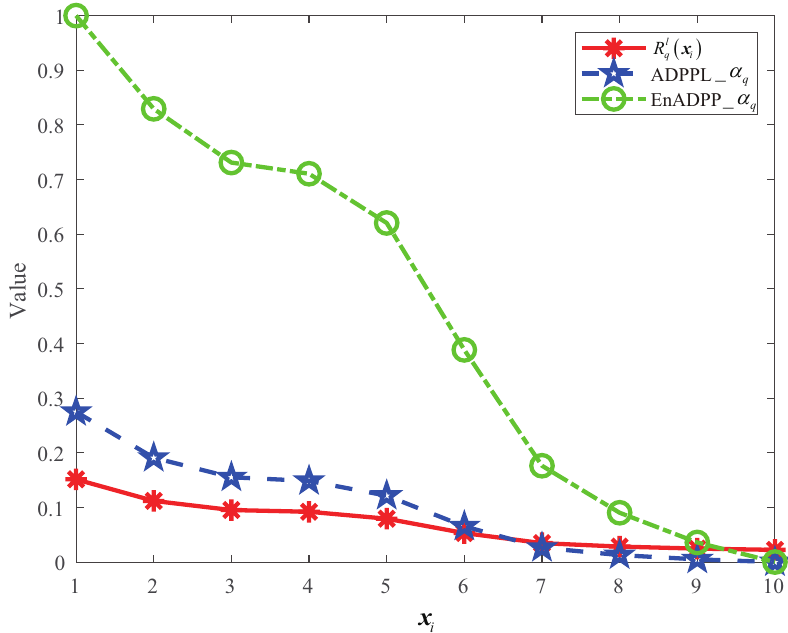
Figure 1. Comparison of the privacy budget ratio between ADPPL and EnADPP.